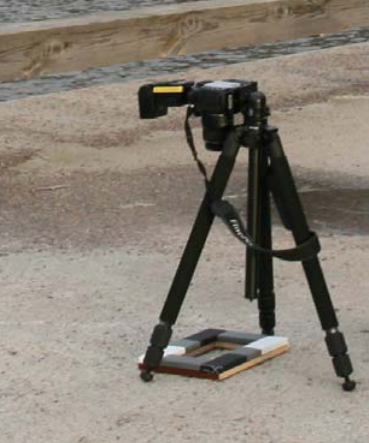
Figure 3. Measurements of concrete in Kivenlahti Harbor with Fuji IS PRO camera and the calibration